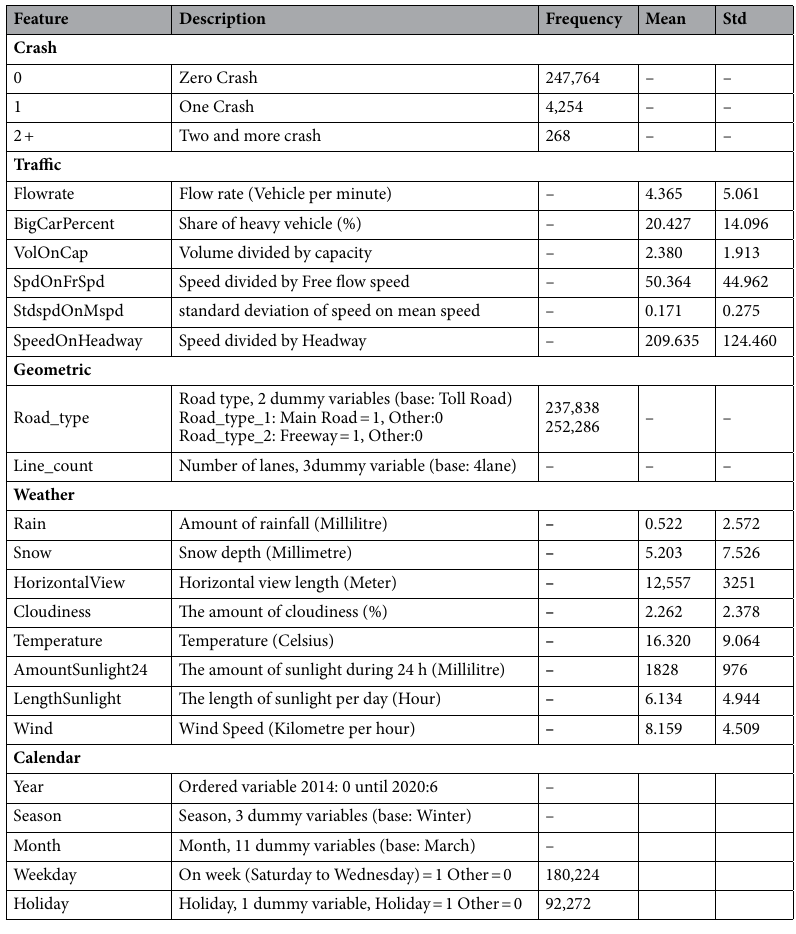
Table 3. Description of explanatory